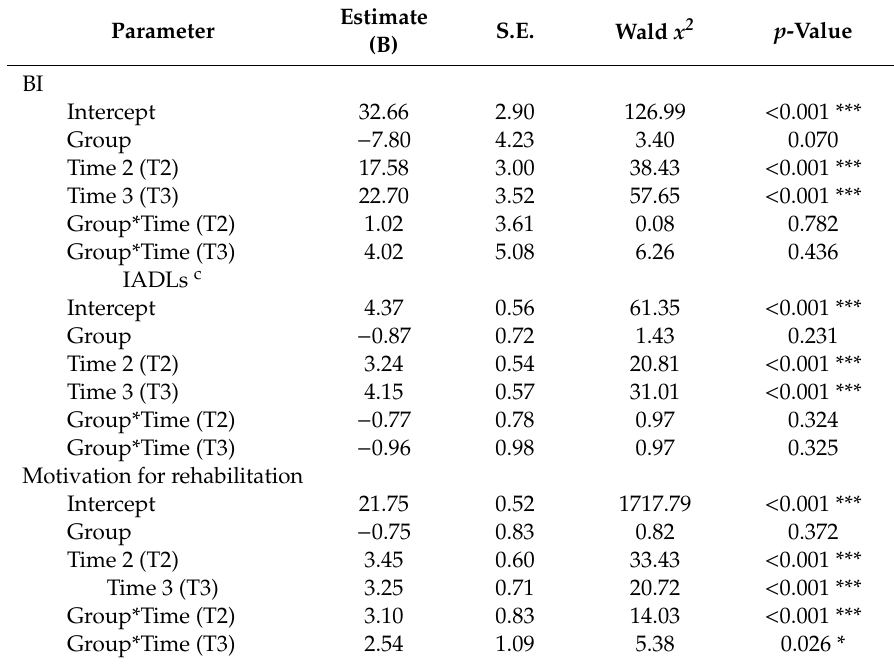
Table 3. Comparisons of di ff erences in BI, IADLs, and rehabilitation motivation scores between the two groups at di ff erent times using the generalized estimating equation